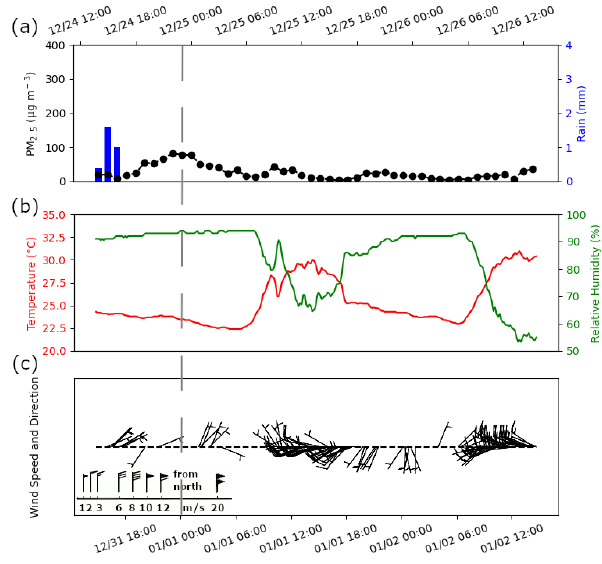
Figure 1. (a) PM 2 . 5 mass concentrations and rain accumulation at hourly resolution (the time shown is local time (UTC + 8); dashed vertical line indicates midnight) as measured from the Manila Ob- servatory main building third floor rooftop ( ∼ 88ma.s.l.) at the same period as the MOUDI size-speciated samples during the fire- work event. Ten-minute-averaged values of (b) temperature and rel- ative humidity, in addition to (c) wind speed and direction. The wind barb legend in panel (c) shows how flags are added to the staff with increasing wind speed and in the direction where the wind comes from. Figures S2 and S3 show the hourly PM 2 . 5 mass concentra- tions and 10min meteorological data before and after the firework event,